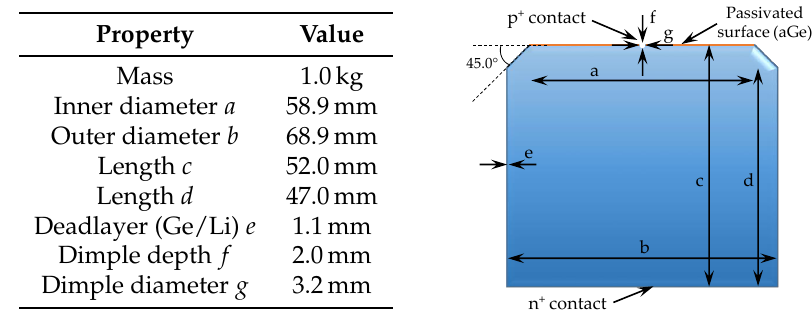
Figure 1. Sketch and parameters of the PPC detector under